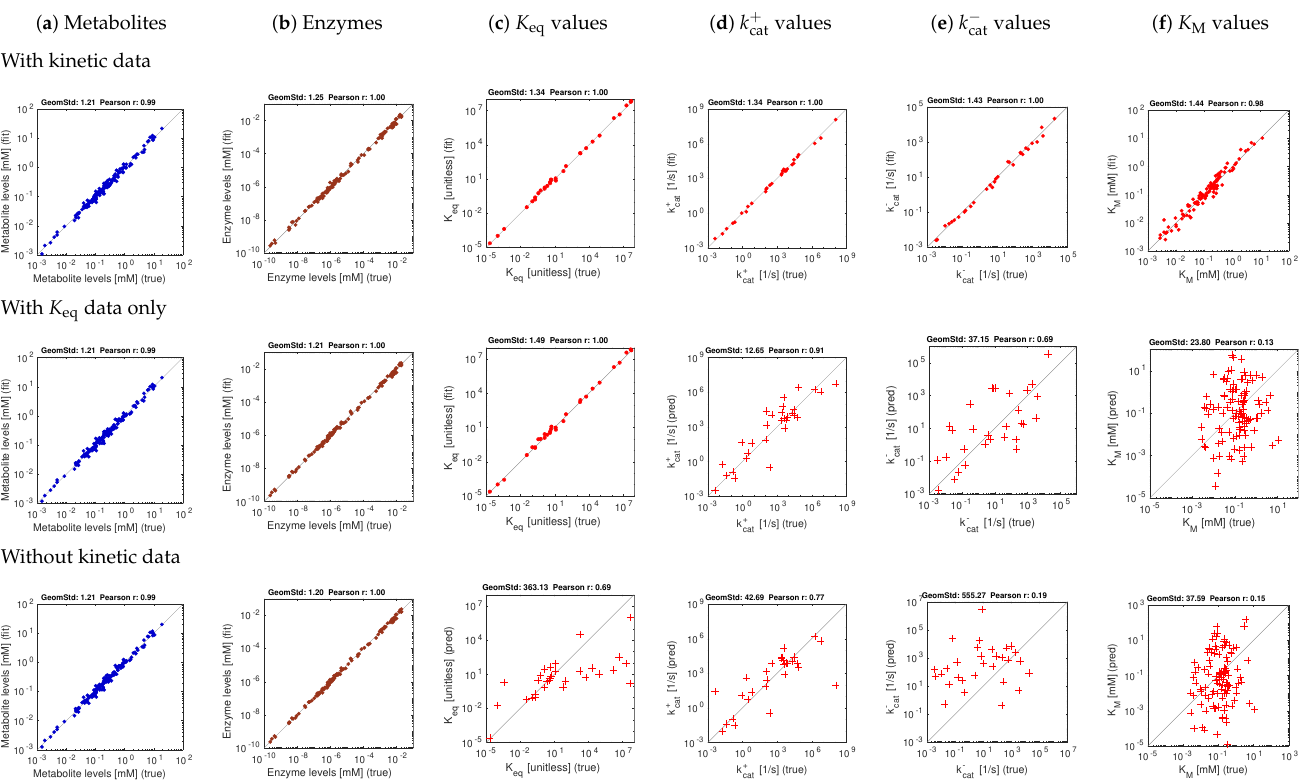
Figure 4. Model balancing results for E. coli model with artificial data (stringency parameter α = 0.5). Same as Figure 3, but with noisy kinetic data and noisy state